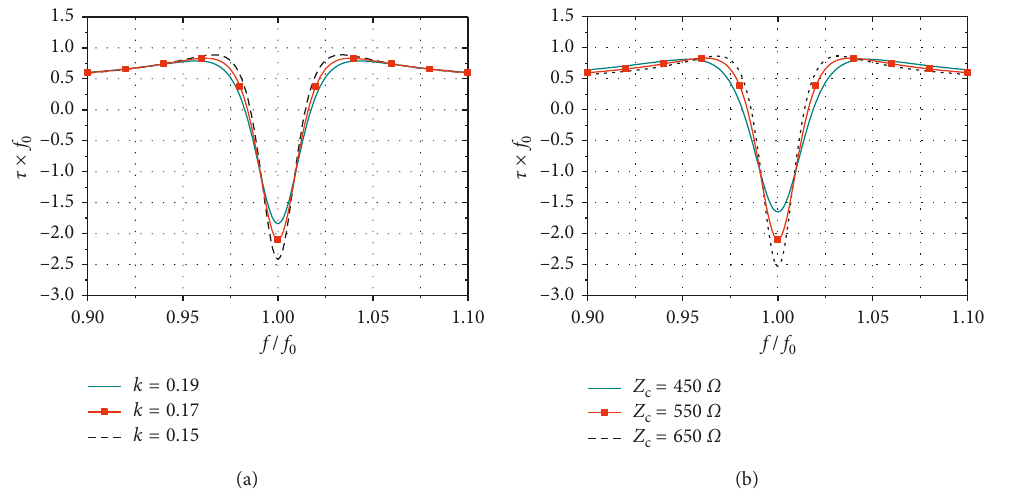
Figure 4: Effect of coupled lines on τ × f 0 of the proposed NGD power divider: (a) k . (b) Z c .